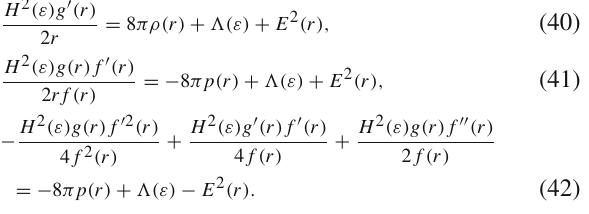
Fig. 3 The entropy S vs the rainbow function ( H (ε) ). We have chosen δ = 0 . 01, D = 1, (cid:8)(ε) = − 1, C 3 Three-dimensional charged AdS gravastars in gravity’s